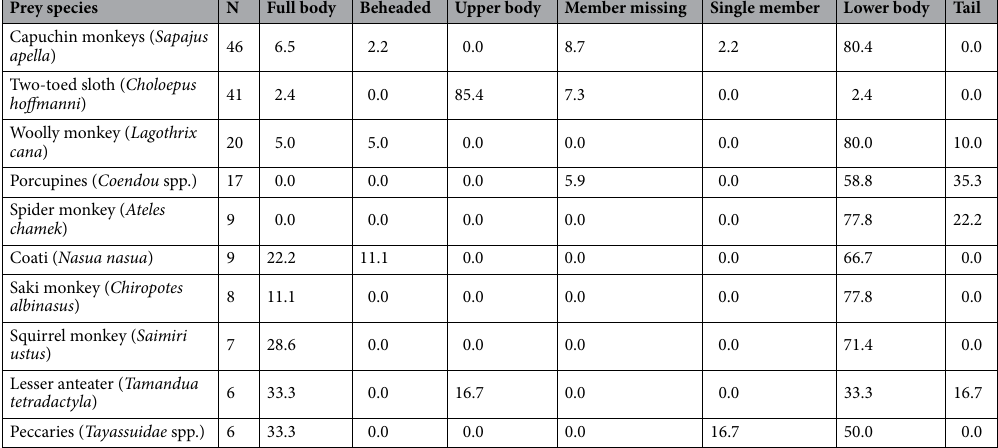
Table 2. Prey body part brought into the nest for the 10 most common prey species. All prey items, other than squirrel monkeys, brought into the nest as a whole carcass (‘Full body’ column) were either infants or juveniles. This table represents species accounting for > 80% of all prey items. For most prey, only the lower body carcass was brought into the nest, except for sloths, for which harpy eagles more frequently bring the upper body. All prey species are represented in percentages of individuals (shown in column N).